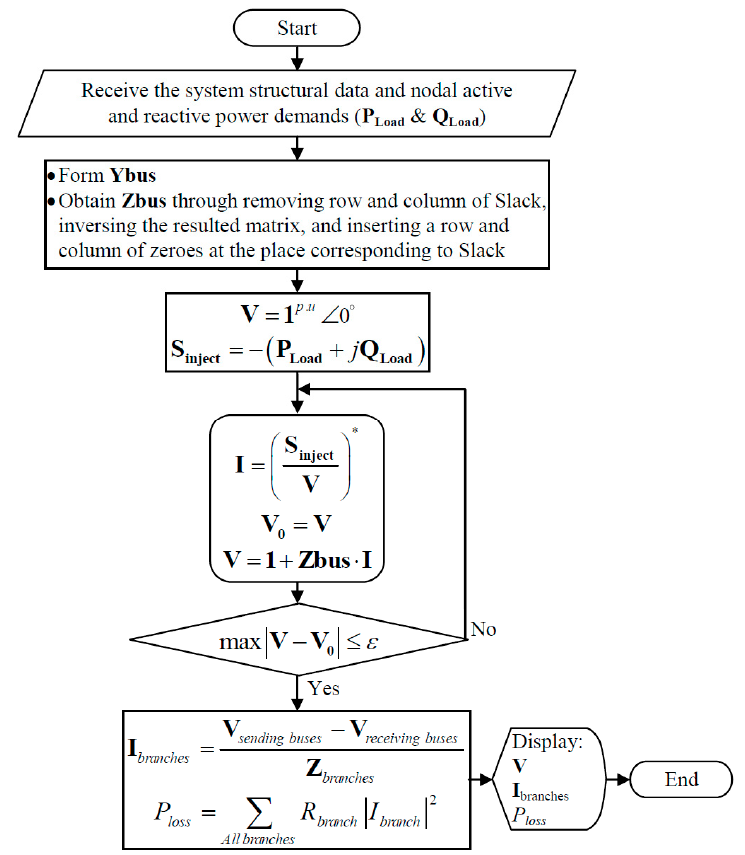
Figure 4. Flowchart of the utilized distribution load flow algorithm.